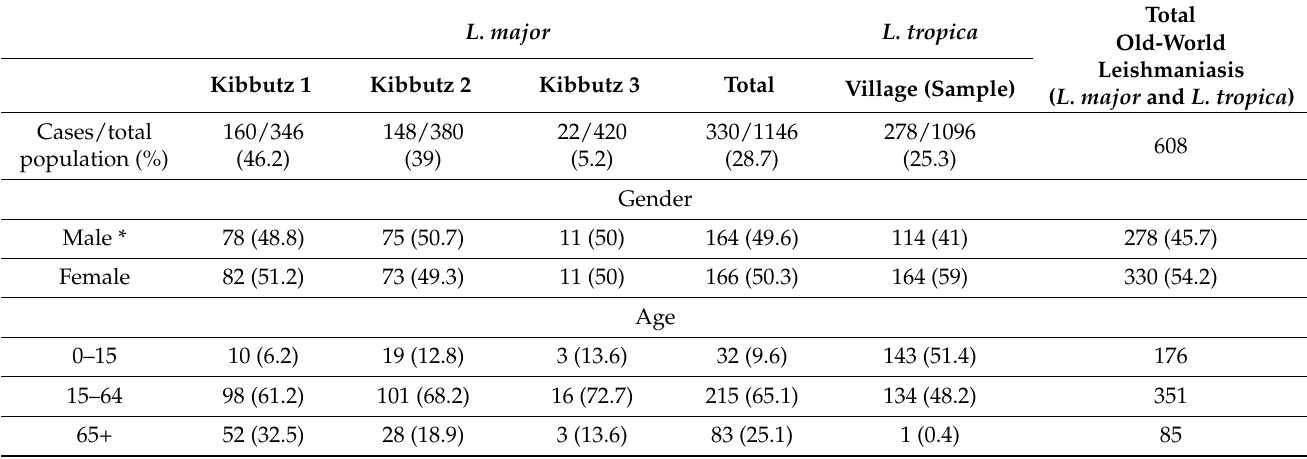
Table 1. CL in three kibbutzim and one village endemic for Leishmania in Israel.